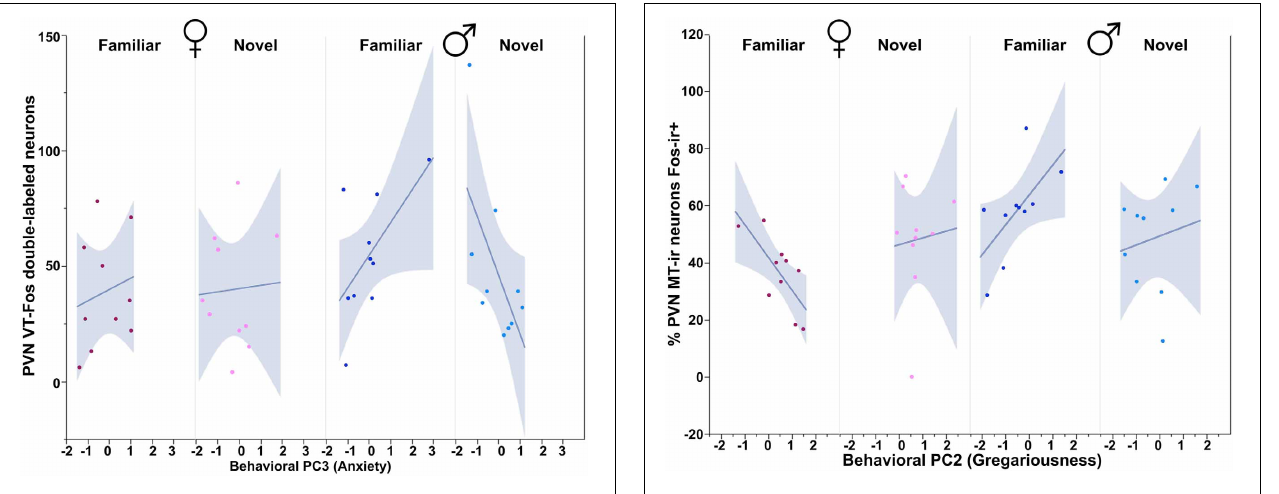
FIGURE 8 | MT-Fos colocalization in the PVN as a function of an interaction between Sex, Context and Behavioral PC2 (Gregariousness). Gregariousness tends to correlate positively in subjects exposed to novel same-sex conspecifics, but negatively in females exposed to familiar conspecifics. Sex × Context × Behavioral PC2 F ( 1 , 32 ) = 3 . 88, p < 0 . 06. The 95% confidence interval is indicated by shading. Table 2 | Principal components matrix of zebra finch VT-MT